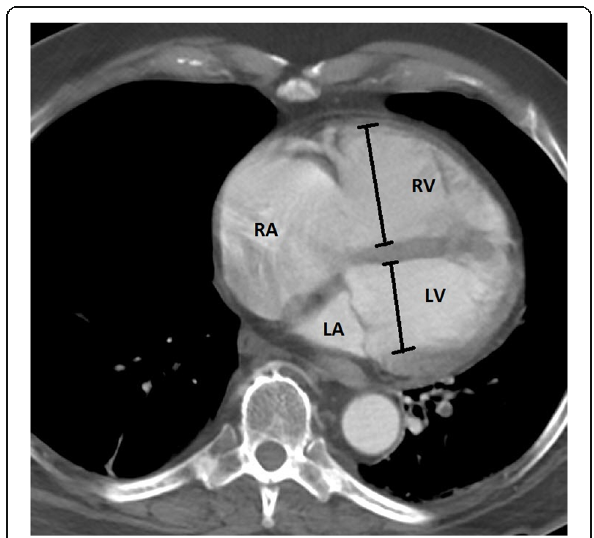
Fig. 9 Measurement of RV/LV ratio. Axial CT images demonstrate the best approximated four-chamber view. Calipers are placed from inner wall to inner wall at the maximal diameter on a view that best approximates the four-chamber view